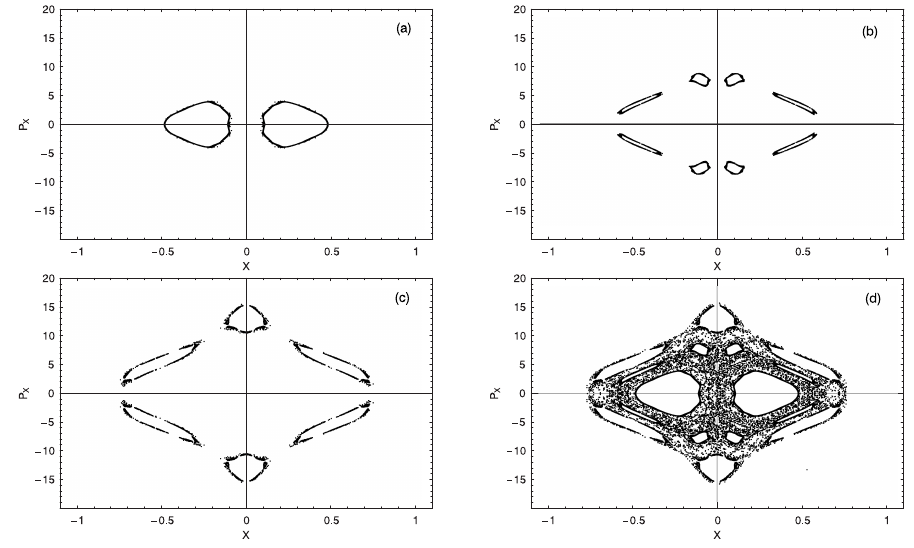
Fig. 2. Panels (a)–(c): the three sticky regions and panel (d): the sticky regions embedded in the chaotic sea.